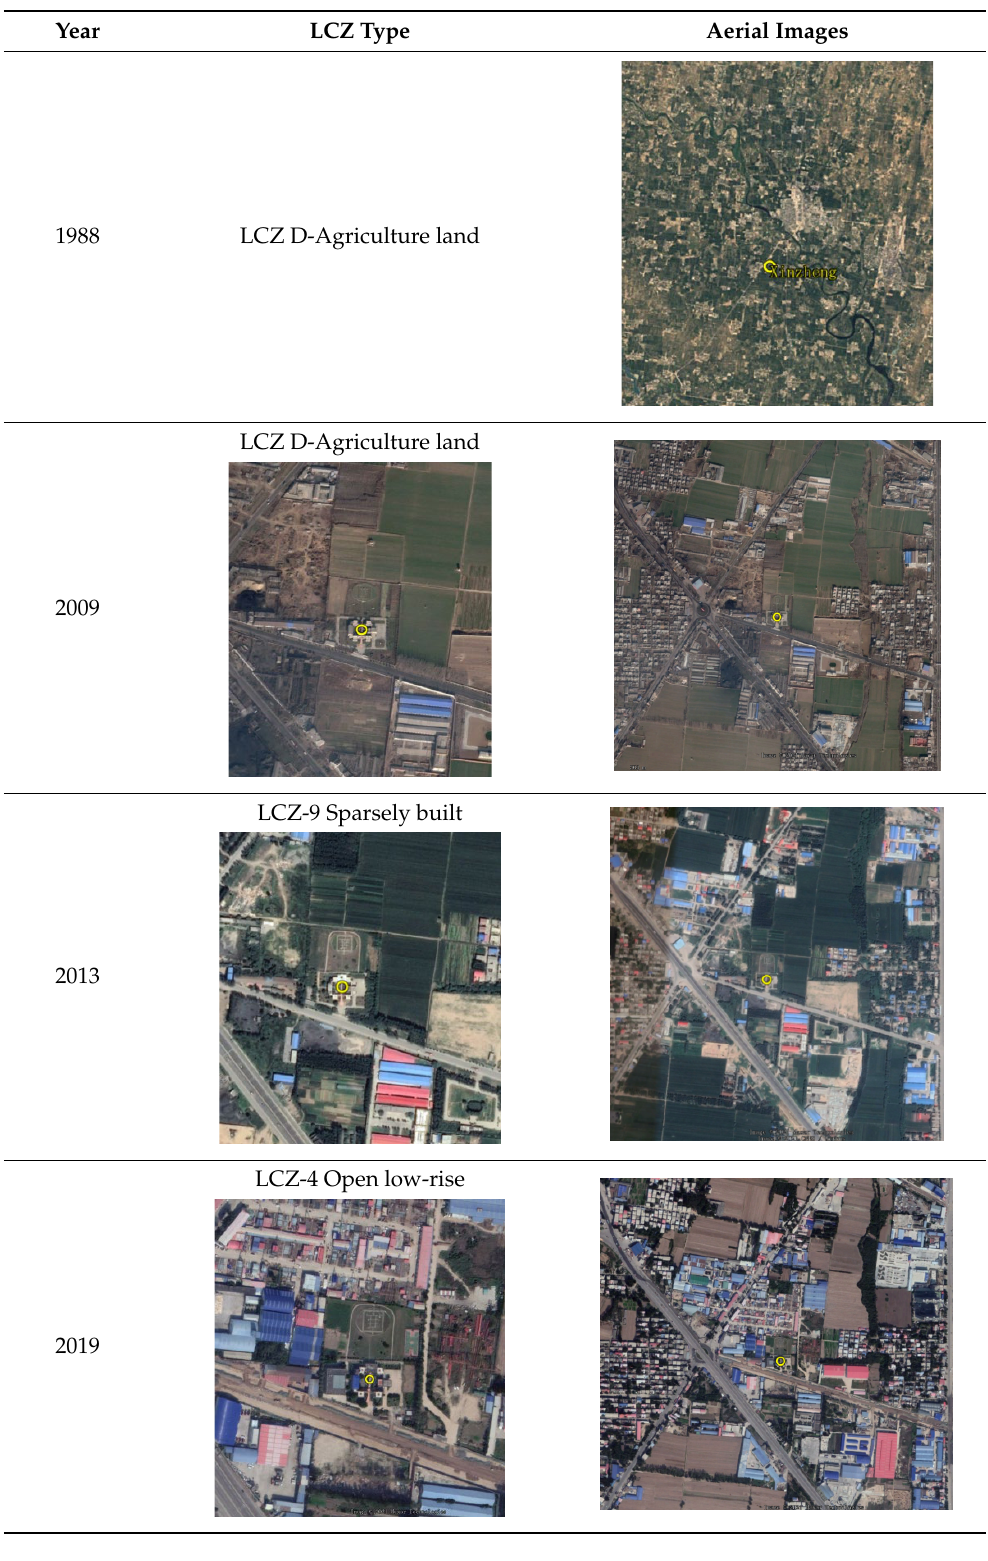
Table A2. Xinzheng national weather station LCZ.